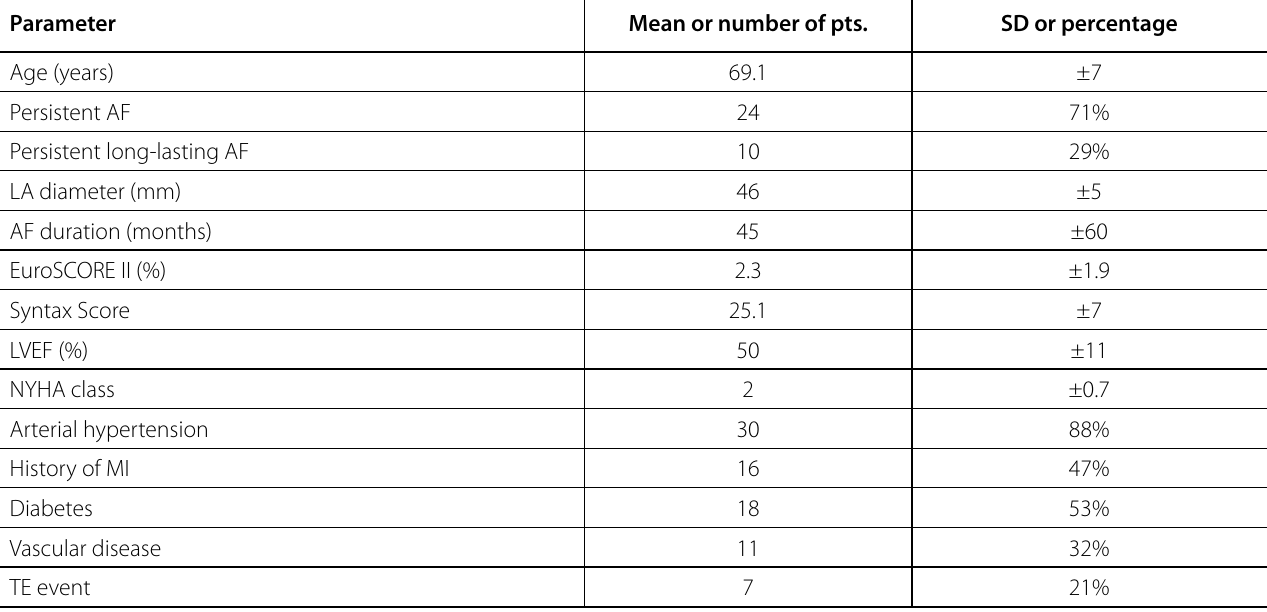
Table 1. Patient characteristics. Parameter Mean or number of